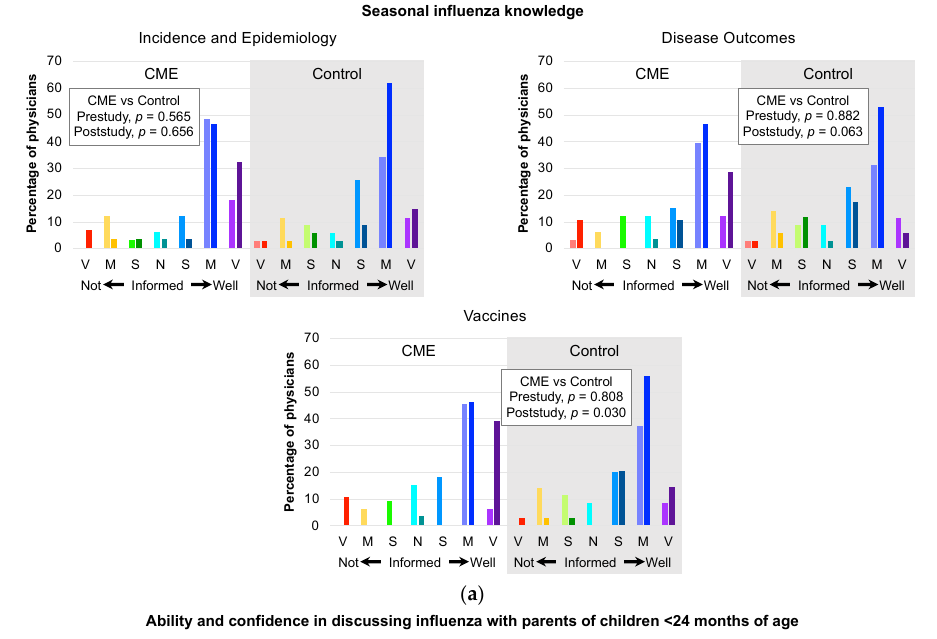
Figure 2. Results of pre- and post-study questionnaire regarding physicians’ knowledge, ability, and confidence in discussing seasonal influenza with parents of children younger than 24 months. ( a ) Seasonal influenza knowledge. Top left question: “How well informed do you feel on seasonal influenza incidence and epidemiology?” Top right question: “How well informed do you feel on the outcomes resulting from pediatric seasonal influenza disease?” Bottom question: “How well informed do you feel on pediatric seasonal influenza vaccines?” ( b ) Left question: “How easy or difficult is it for you to discuss influenza vaccines with parents?” Right question: “What is your level of confidence in discussing influenza vaccines with parents?” For each color pairing, the lighter shade represents the pre-study data and the darker shade represents the post-study data. P values represent comparisons between study groups on all answers to each question and were assessed with Pearson Chi-square. V, very; M, moderately; S, slightly; N, neither. Table 2. Mixed model–binary logistic regression for the odds of immunization following a physician parent interaction 1 .